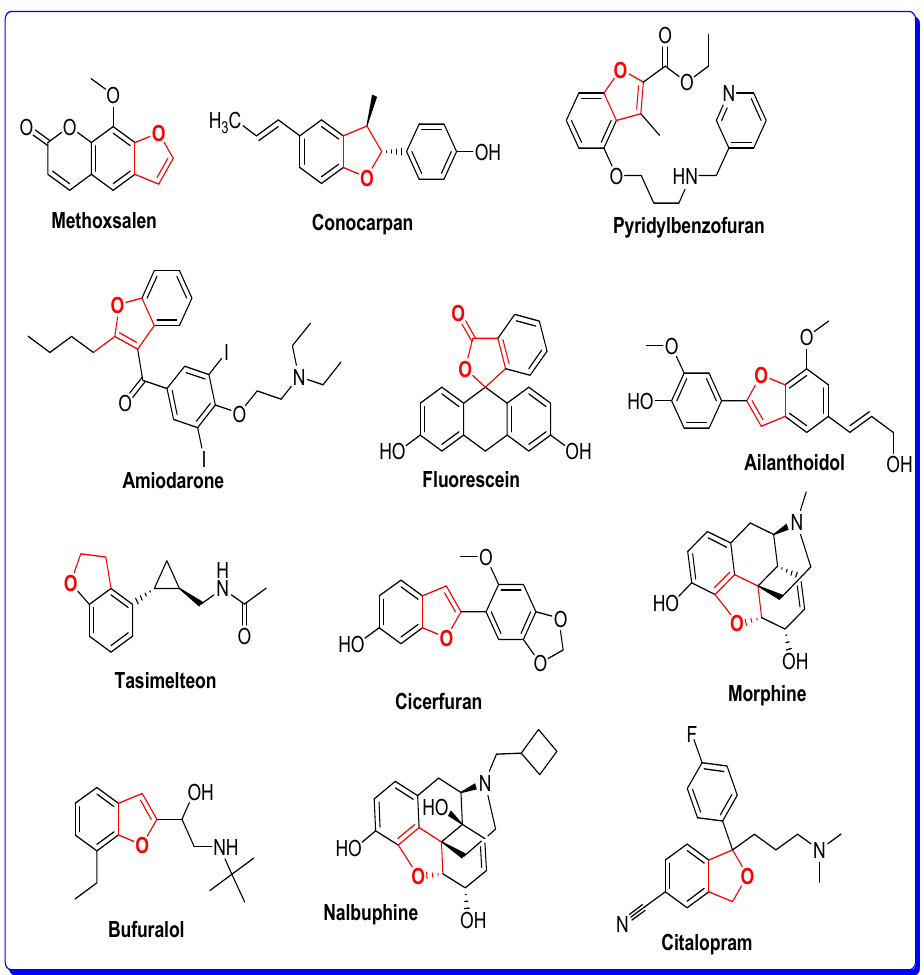
Figure 2. Some of the most famous benzofuran core-based clinical drugs. The Rationale of Molecular Design of Bromobenzofuran-oxadiazoles BF1-9 against HepG2 Cancer Cell Line